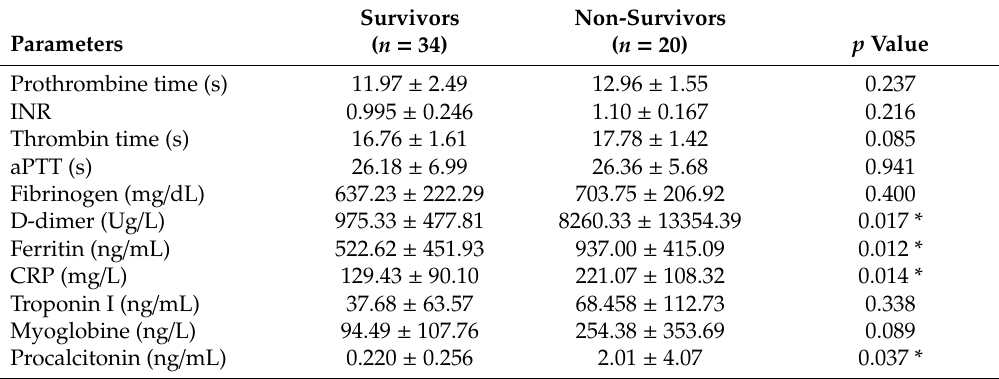
Table 3. Coagulation and immune parameters at admission in hospitalized patients with severe Covid-19. Abbreviations: INR, international normalized ratio; aPTT, activated partial thromboplastin time; CRP, C-reactive protein. Normality of data distribution was estimated by the Shapiro–Wilk test. The unpaired Student’s t -test was used to compare numerical variables and data are presented as mean ± standard deviation. * Di ff erences were considered significant when p < 0.05.